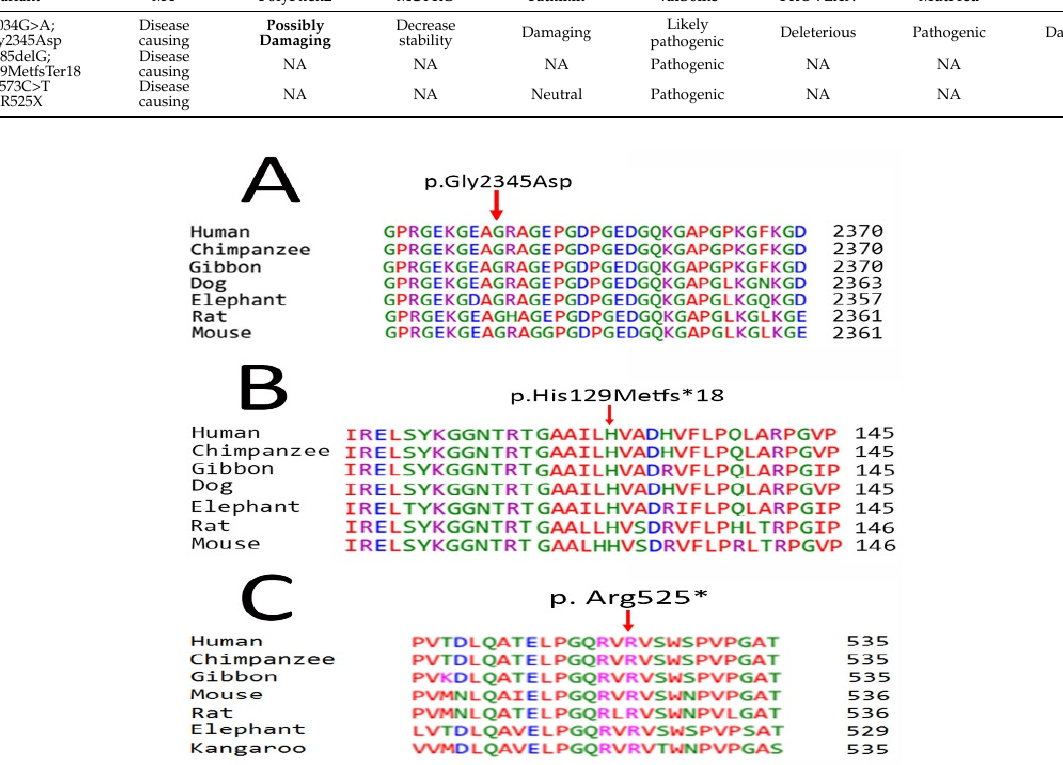
Table 2. Pathogenicity detection of COL7A1 variants.